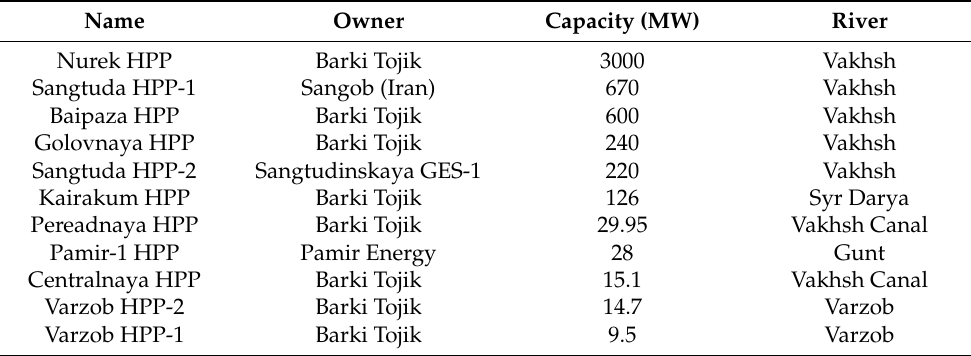
Table 2. Biggest hydropower plants in